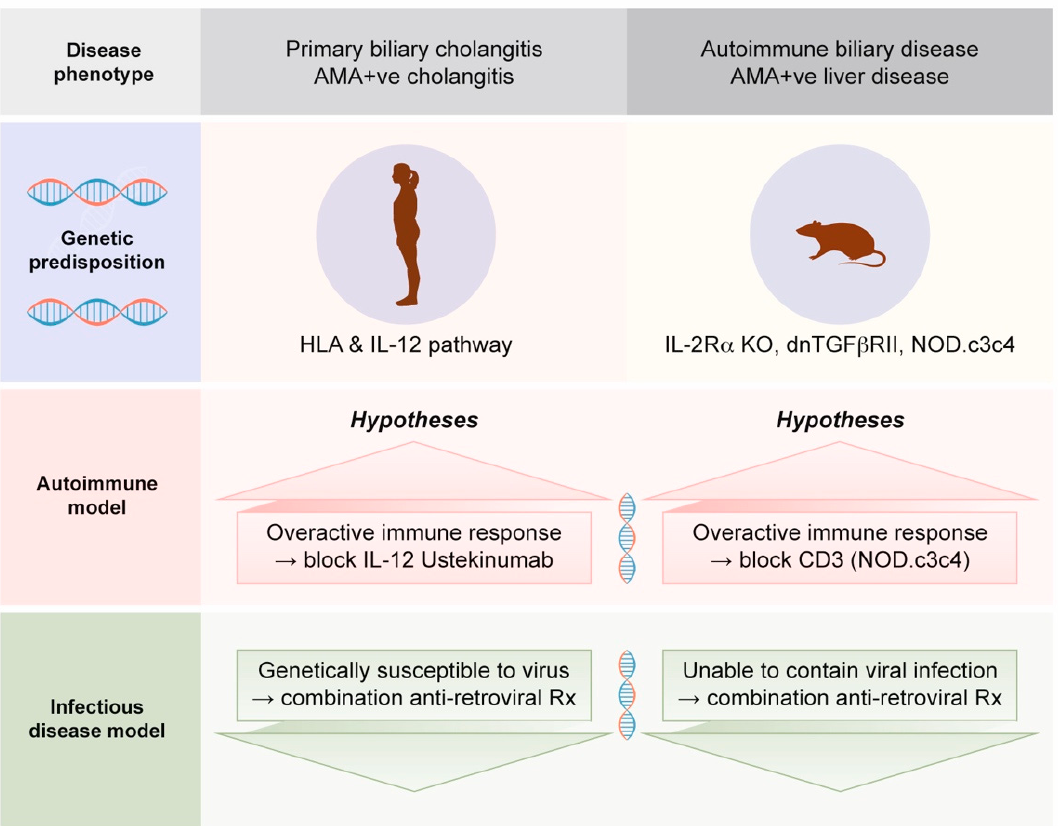
Figure 1. Autoimmune and infectious disease models for interpreting the genetic predisposition to biliary disease. Genome-wide association studies of patients with PBC and animal models of spon- taneous autoimmune biliary disease provide alternative hypotheses for the development of cholan- gitis. In the autoimmune model, it is assumed that the immune system is the origin of disease; there- fore, treatment is geared towards immunosuppression or immune targeted therapy. Whereas if chol- angitis is triggered by a betaretrovirus, the genetic susceptibility is likely to provide a degree of im- munodeficiency to lower resistance to viral infection, and therefore anti-retroviral therapy is the treatment of choice.